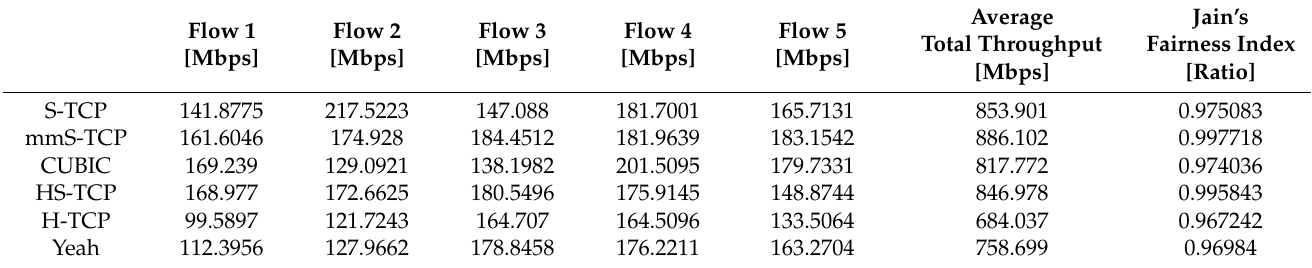
Figure 14. Throughput comparison of five flows according to the CCAs: ( a ) CUBIC; ( b ) S-TCP; ( c ) mmS-TCP; ( d ) H-TCP; ( e ) HS-TCP; ( f ) Yeah. Table 3. Comparisons of Jain’s fairness index, the throughput of each flow, and the average total